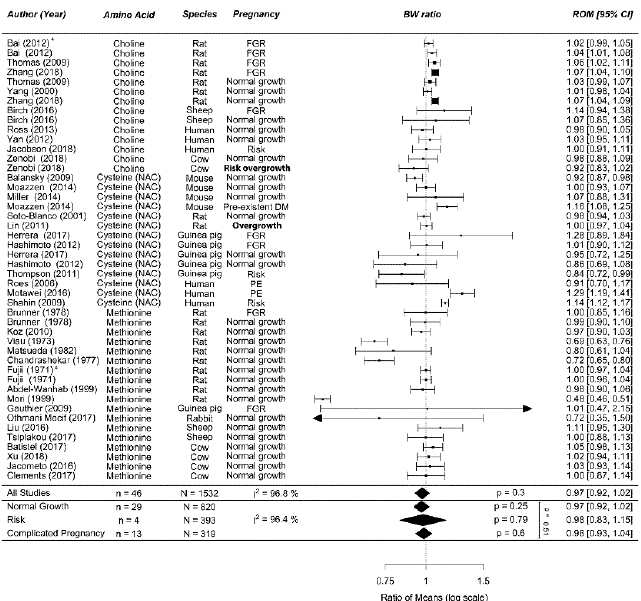
Figure 5. Meta-analysis on prenatal supplementation of methyl donors on fetal / birth weight (BW): Prenatal supplementation of methyl donors did not a ff ect birth weight in normal-growth, risk populations or complicated pregnancies. Data are ordered within each amino acid (AA) from smallest to largest animal. Data represent pooled estimates expressed as a ratio of means (ROM) with a 95% confidence interval (CI) using a random e ff ect model. Residual I 2 is shown. Only two studies included (risk of) overgrowth as their study population (bold). Some studies had multiple cohorts split up by sex indicated by *, in which the upper line represents male o ff spring compared to the next line which represents female o ff spring. FGR, fetal growth restriction; I 2 , heterogeneity; NAC, N -acetyl Cysteine; PE, preeclampsia; DM, diabetes mellitus.